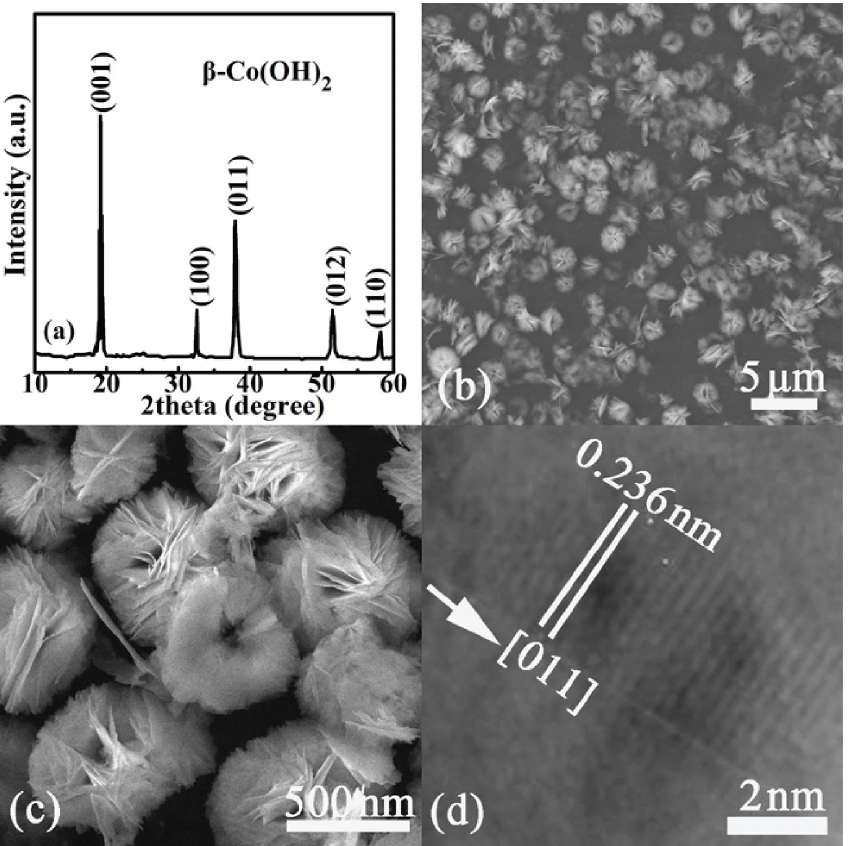
Figure 1. (a) XRD pattern, (b) and (c) SEM images with different magnifications for the flower-like Co(OH) image of